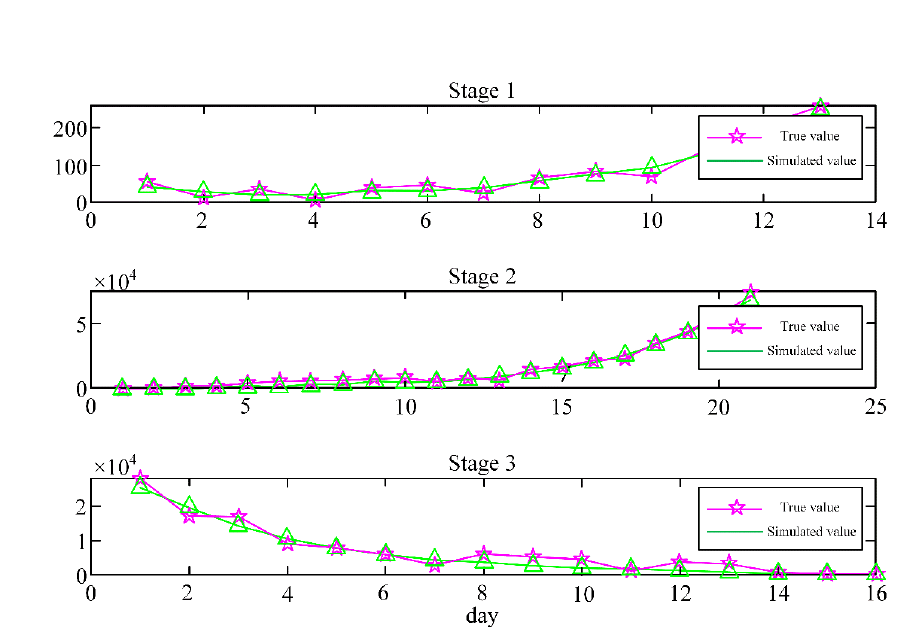
Figure 7. Model reliability test diagram.